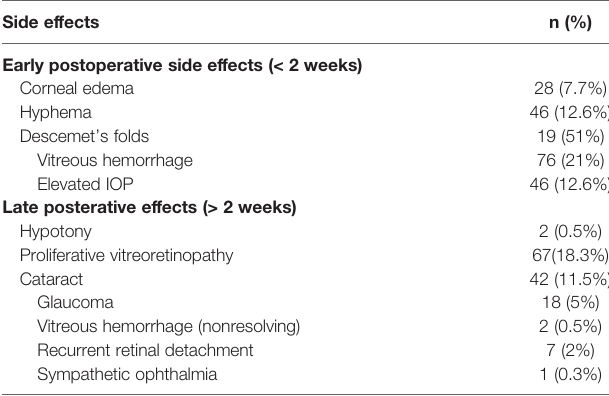
TABLE 2 | Surgical Resection (Partial Transscleral Sclerouvectomy Combine with Mircoinvasive Vitrectomy and Reconstruction of the Eyeball) of Intraocular Tumors in 366 Patients: Early and Late Surgical Side